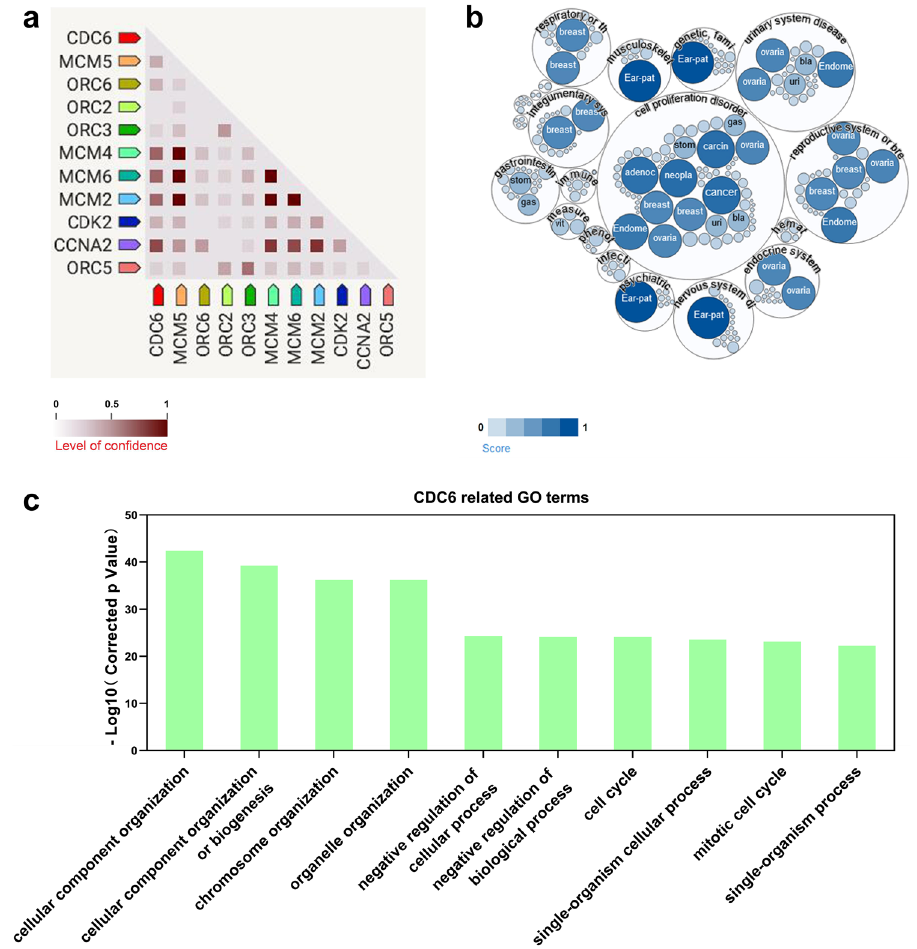
Figure 7. Protein–protein interactions and the roles of cell division cycle 6 ( CDC6 ) in diseases. (a) Diagram of the top 10 factors interacting with CDC6 . (b) Enrichment diagram of CDC6 -related diseases. The depth of the color represents the degree of correlation. (c) The top ten dysregulated GO terms associated with CDC6 in the systemic lupus erythematosus (SLE) group compared to the control (CTRL)